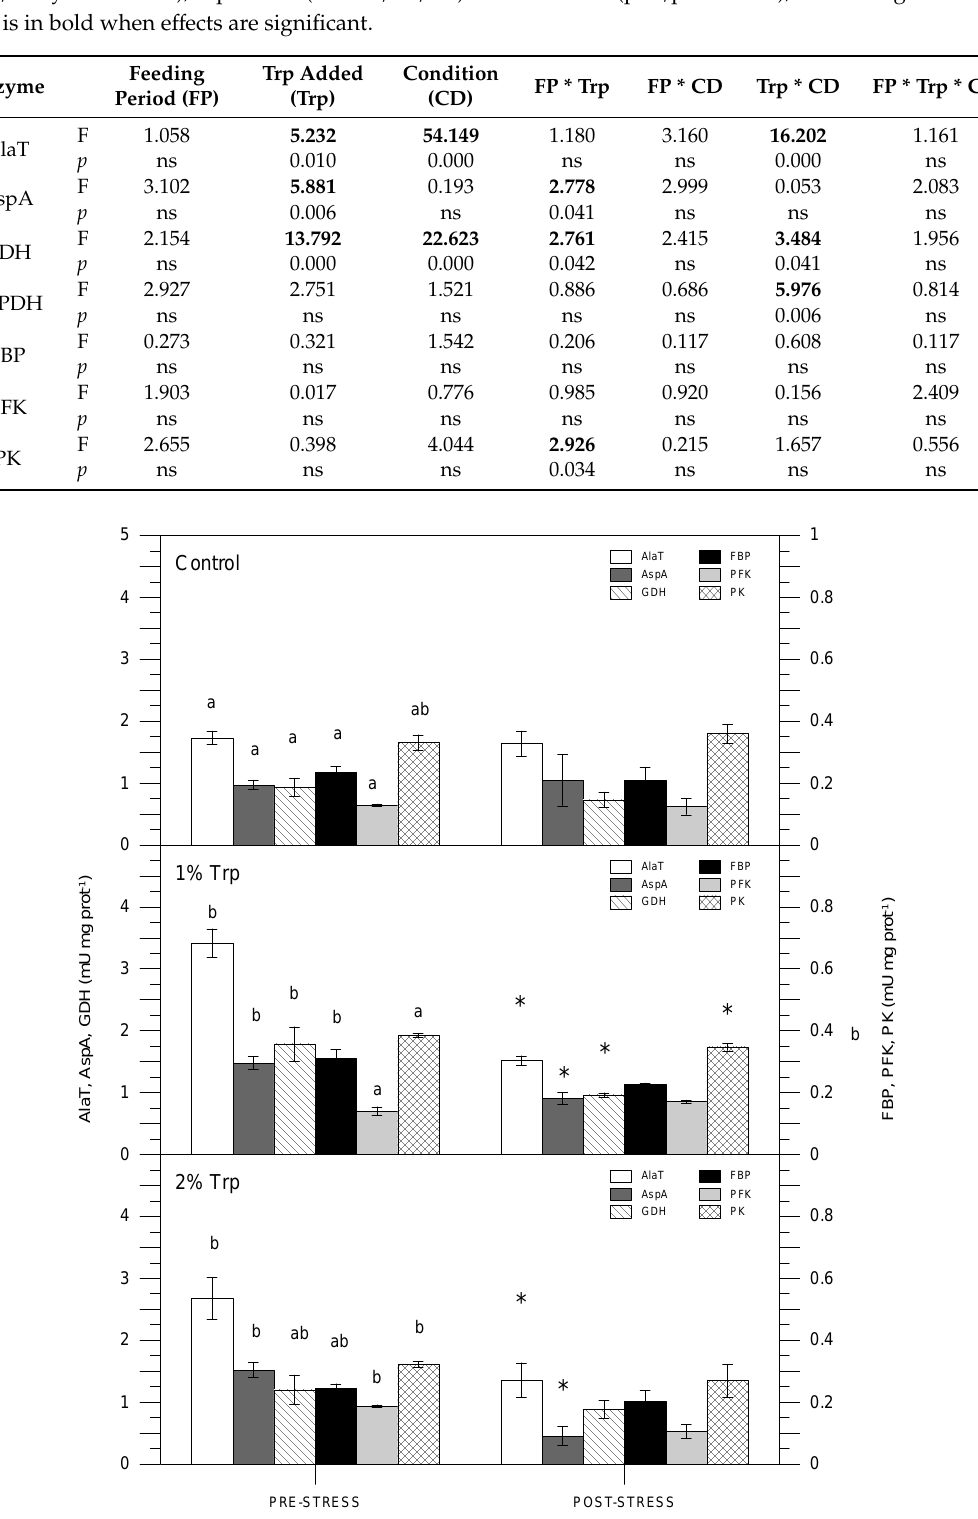
Figure 5. Hepatic enzyme activities (AlaT, AspA, GDH, FBP, PFK and PK) for the two-day treatment. Different letters indicate significant differences among groups (experimental feeds) within each condition, and asterisks show significant differences between pre- and post-stress condition within each feed type.